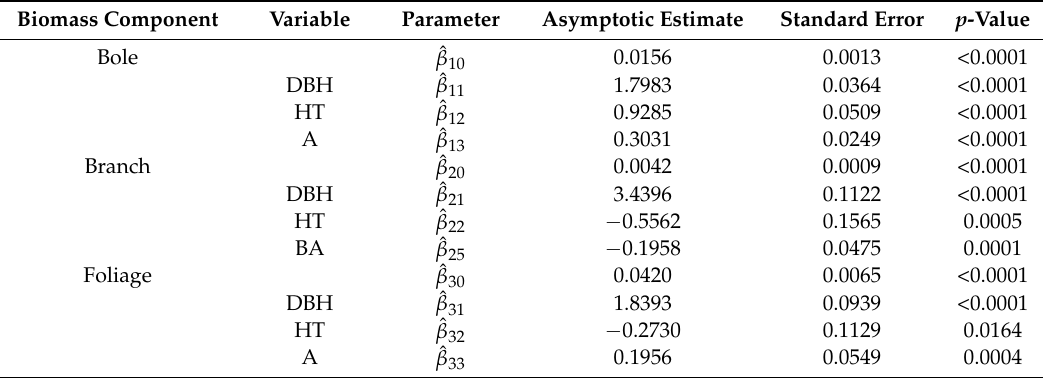
Table 8. Parameter estimates and their asymptotic standard error and p -values for the additive biomass equation system based on diameter at breast height (DBH), height (HT), age (A) and basal area (BA) (Model System VI).